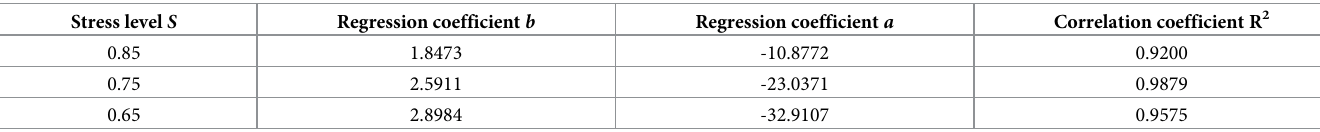
Table 8. Regression parameter